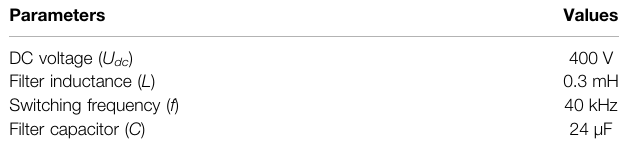
TABLE 2 | Experimental parameters. Parameters